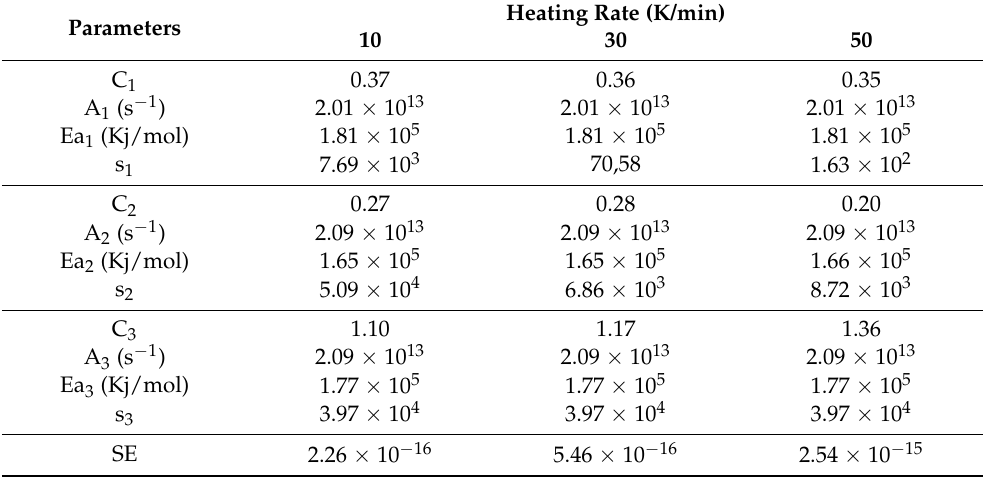
Table 10. Kinetics results DAEM model for the EFB + 3% Zn sample.